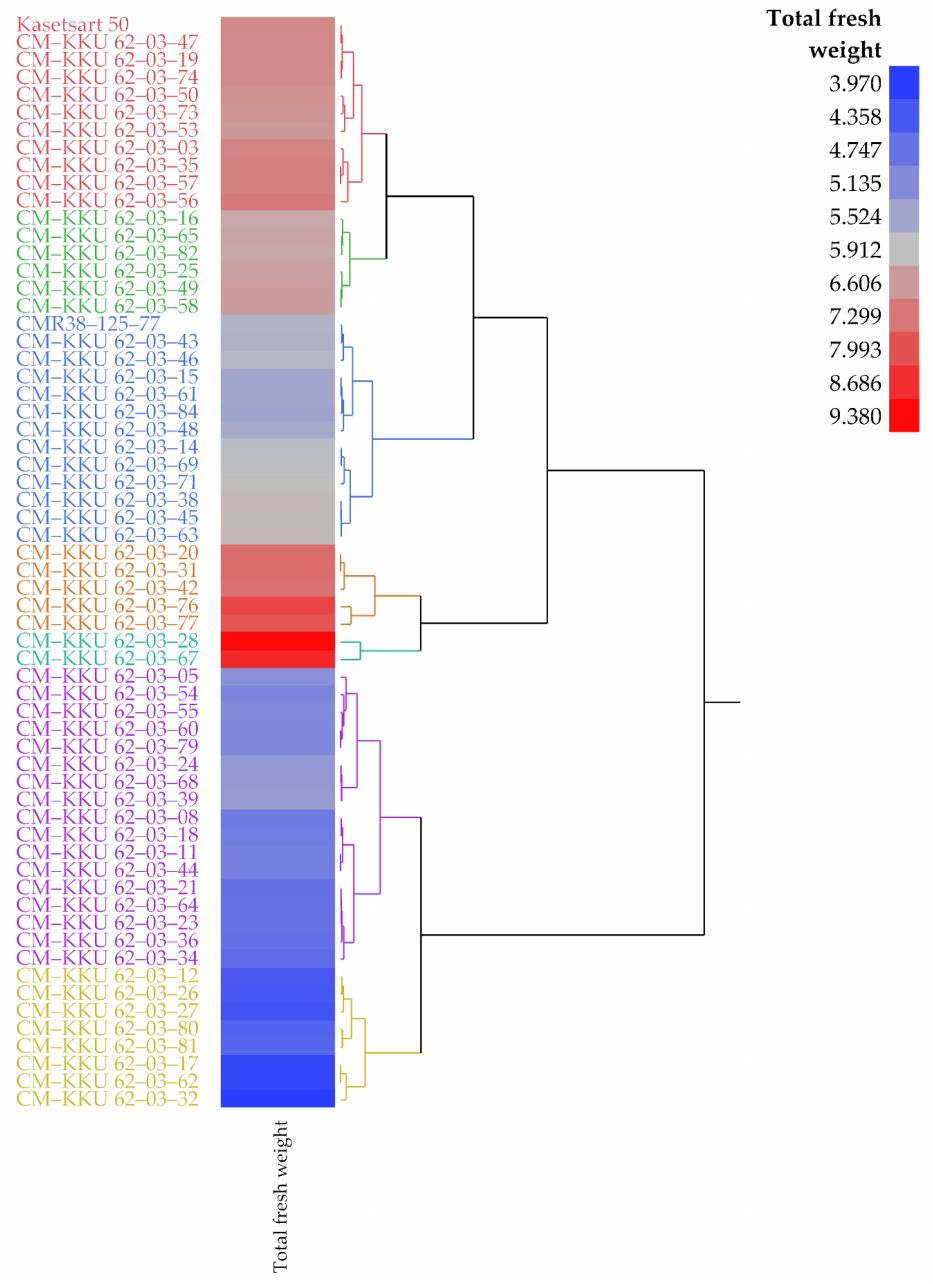
Figure 4. Dendrogram of Kasetsart 50 and CMR38–125–77 genotypes and 60 segregating